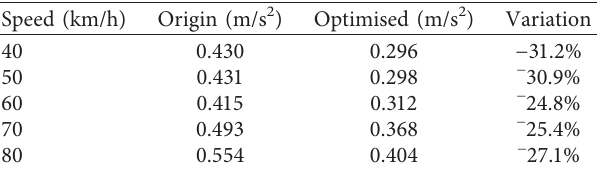
Table 3: Comparison of driver weighted acceleration r.m.s. before and after optimisation.